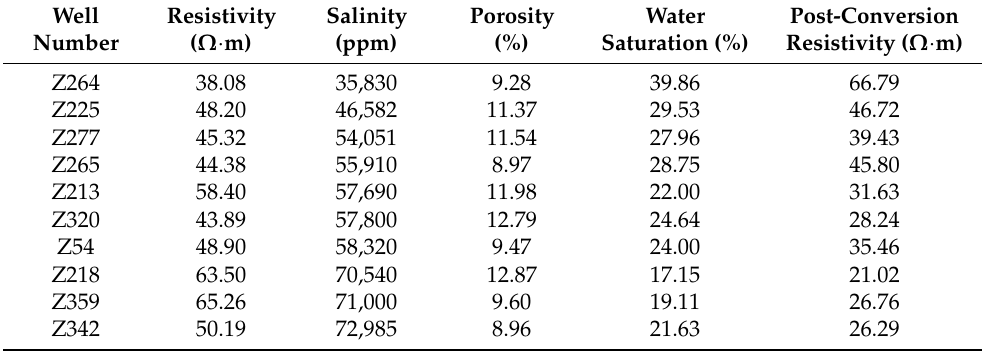
Table 1. Exploratory well data used to establish the basic plate with water saturation